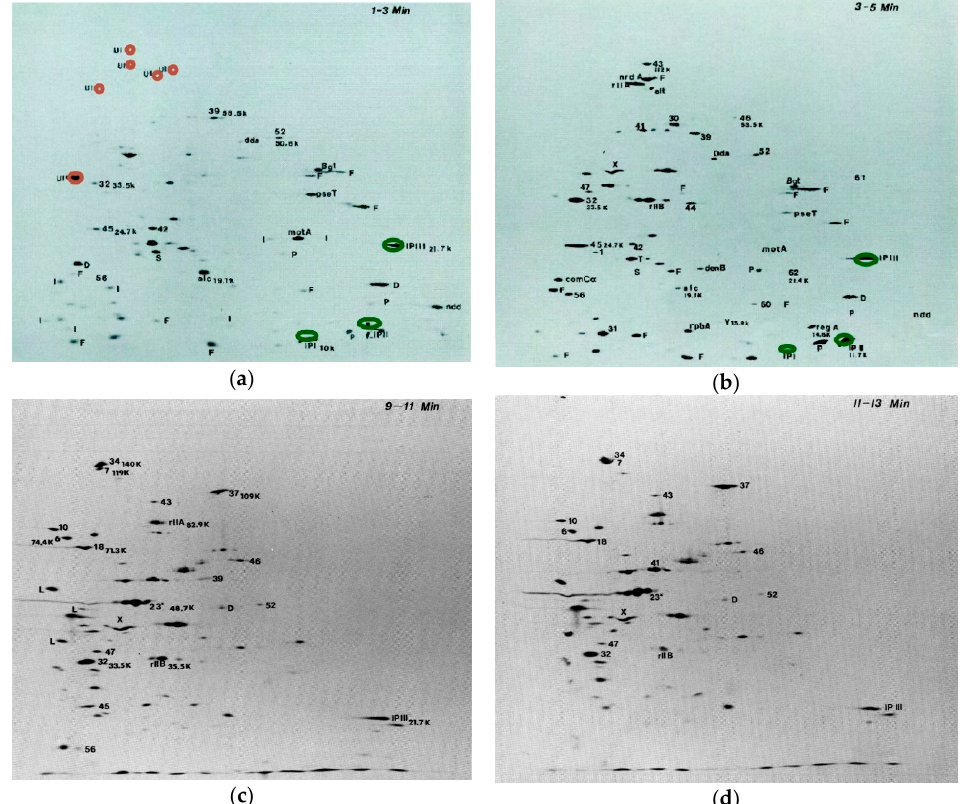
Figure 2. Two dimensional (2D) polyacrylamide gels of protein expression at 1–3 min ( a ); 3–5 min ( b ); 9–11 min ( c ), and 11–13 min ( d ) after T4 infection: An exponential-phase culture of E. coli B in M9 at